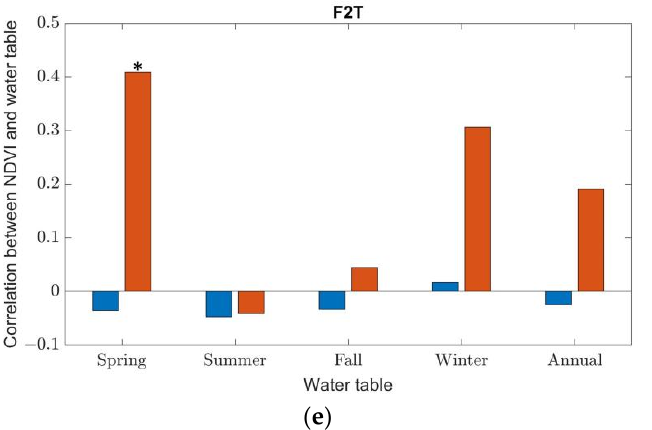
Figure 9. Correlations of grid-wise mean annual maximum NDVI to seasonal/annual mean saltwater tables (SWTs) and groundwater tables (GWTs) for different types of wetland evolution. ( a ) H2N: Emergent herbaceous wetlands degrading to non-vegetated areas (Type 6 degradation). Due to the fact that this triangular irregular grid was next to the sea (Figure 8a), and the simulated SWT was above the land surface, there was no distinction between saltwater and ground freshwater. Therefore, only the grid-wise mean annual maximum NDVI time series with seasonal/annual mean SWTs were presented; ( b ) H2H: Emergent herbaceous wetlands without degradation; ( c ) T2H: Transitional forested wetlands degrading to emergent herbaceous wetlands (Type 5 degradation); ( d ) T2T: Transitional forested wetlands without degradation; ( e ) F2T: Forested wetlands degrading to transitional forested wetlands (Type 3 degradation). p < 0.05 is denoted with a single star (*); p < 0.01 is denoted with double stars (**).